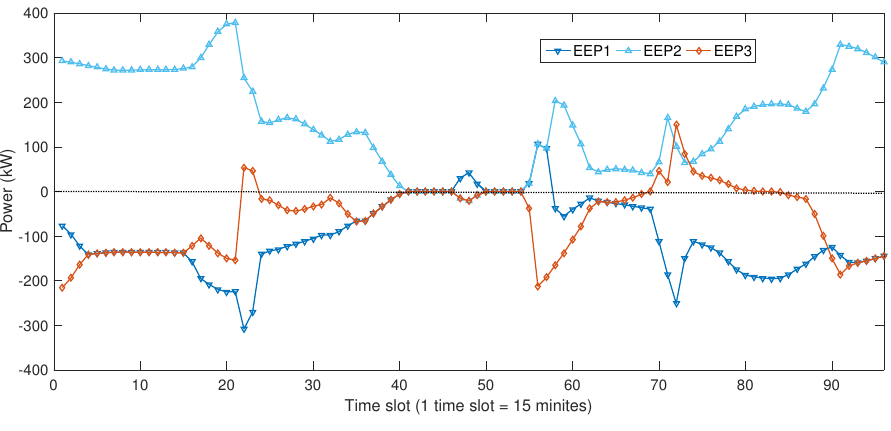
Figure 9. Decided exchanging power among